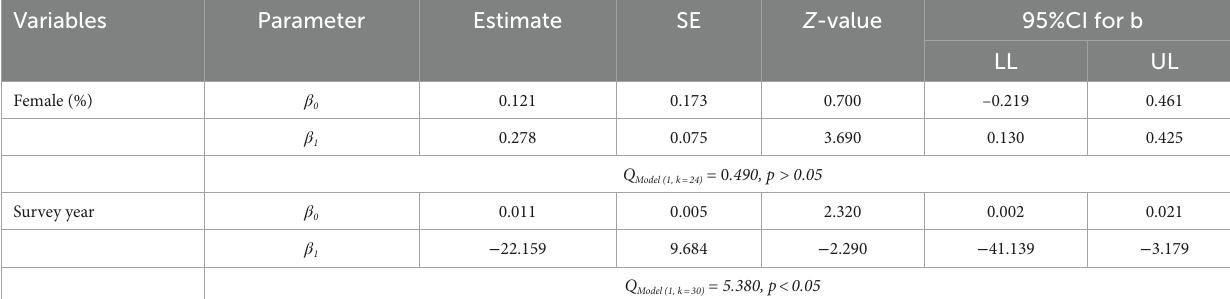
TABLE 4 Meta-regression analysis of gender and survey